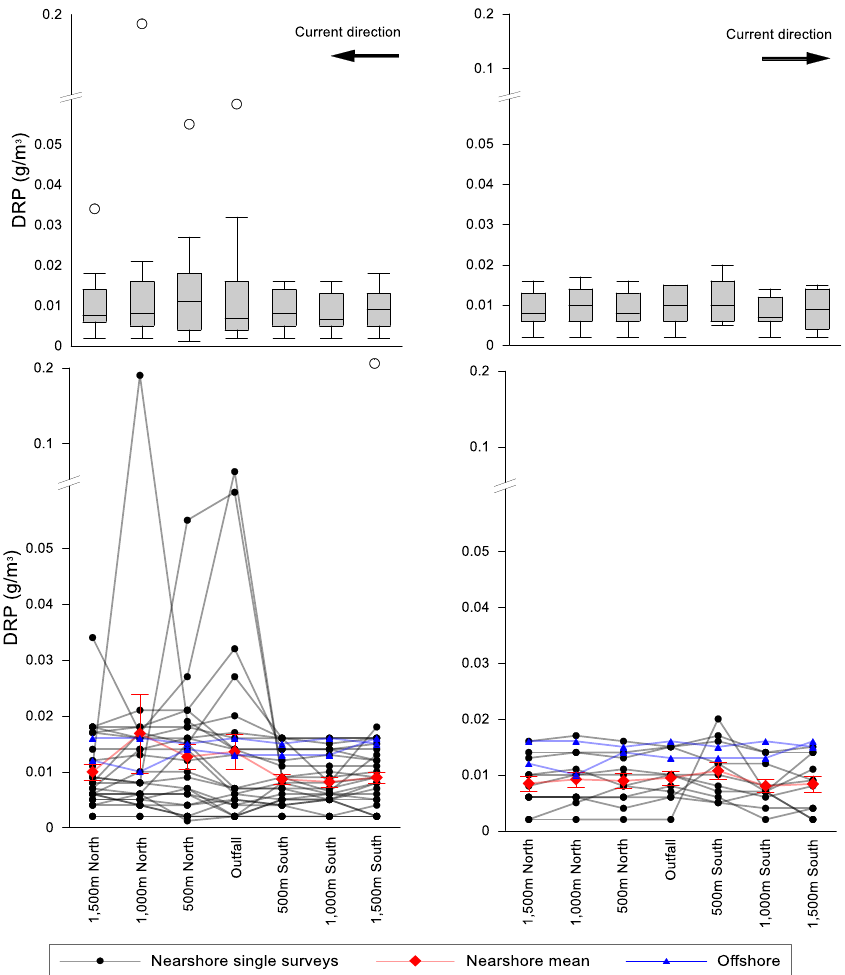
Figure 9. Seawater-dissolved reactive phosphorus (DRP) concentrations within the mixing zone of the meat processing plant discharge under north-flowing ( left ) and south-flowing ( right ) current flows. Box and whisker plots ( top ) indicate median values and upper and lower quartiles ( grey box ). Whiskers were set with a factor value of 1.5.